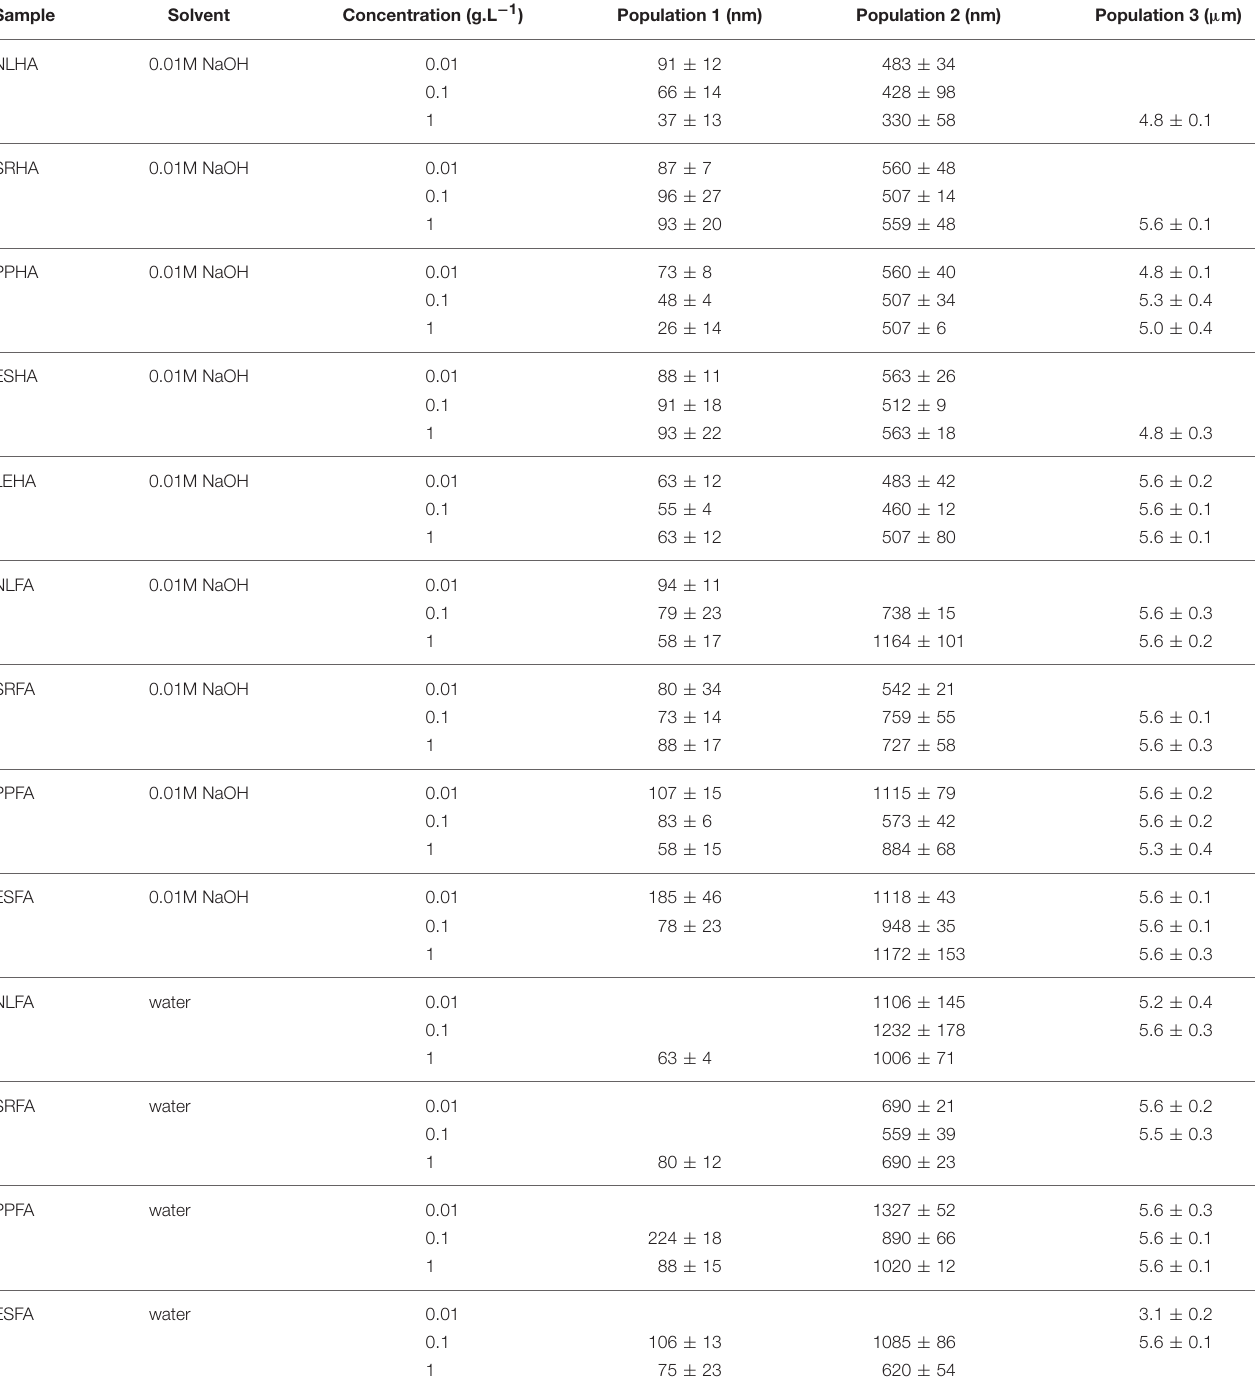
TABLE 1 | Average diameter of three volume based particle populations of humic and fulvic acids. Sample